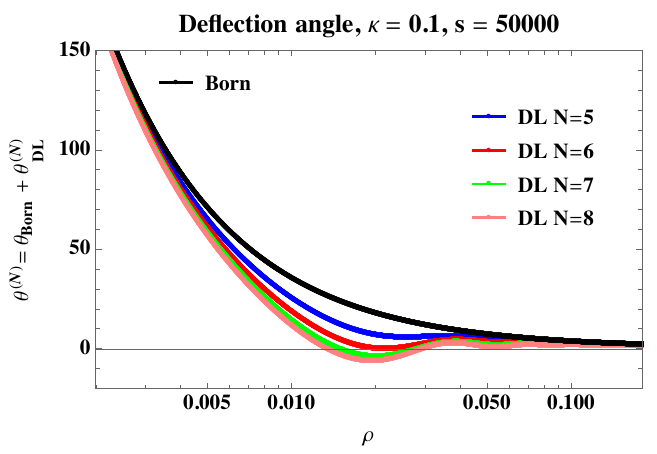
Figure 12 . Graviton’s de(cid:13)ection angle for a large value of the center of mass energy as a function of the impact parameter space with and without DL corrections for N = 5 ; 6 ; 7 ; 8 supergravity